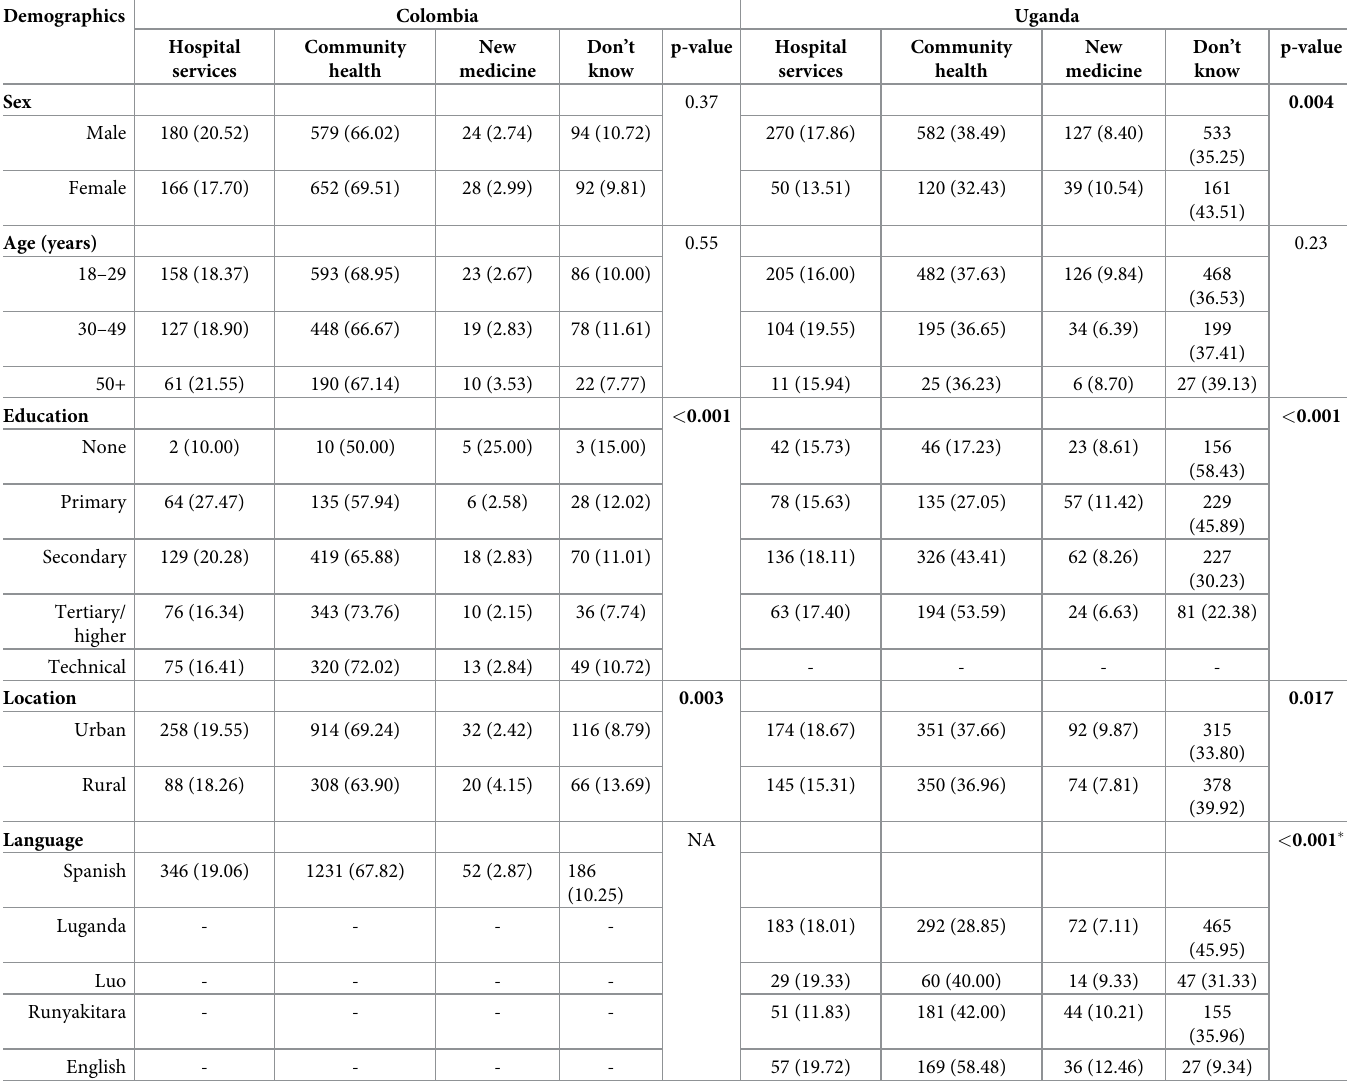
Table 4. Survey understanding by demographics in Colombia and Uganda, n